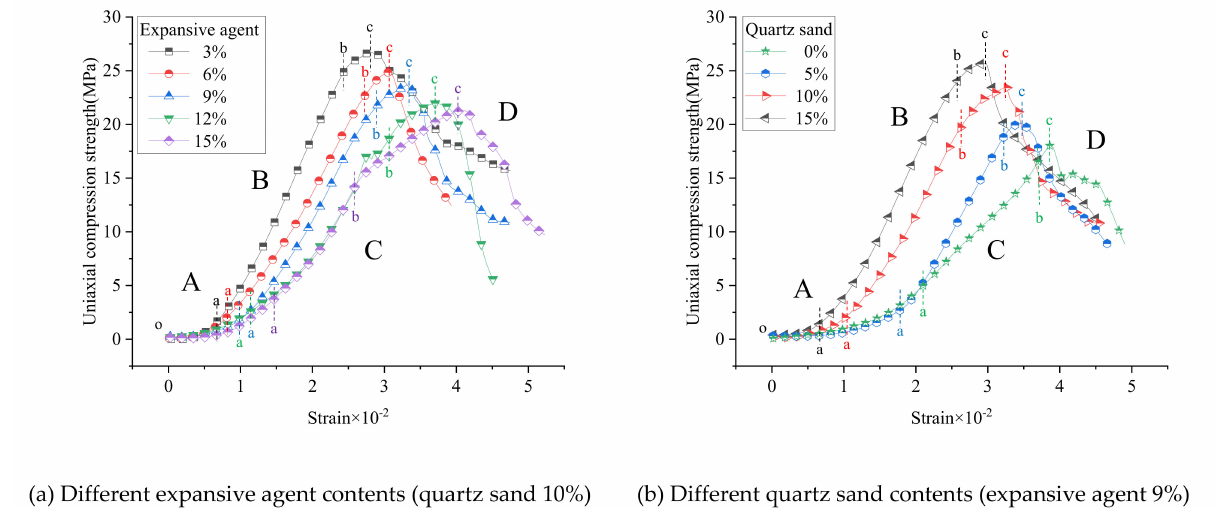
Figure 7. Stress–strain curves of expansive grout